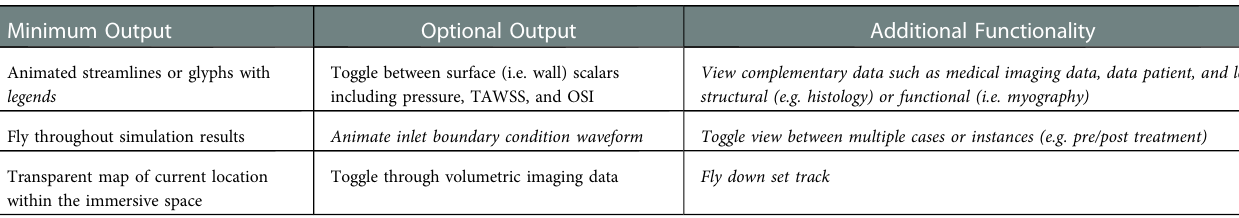
TABLE 2 Minimum and optional output, along with additional functionality, of the unity template. Italicized text indicates the user must manually alter the data into the unity prefabricated template. Minimum